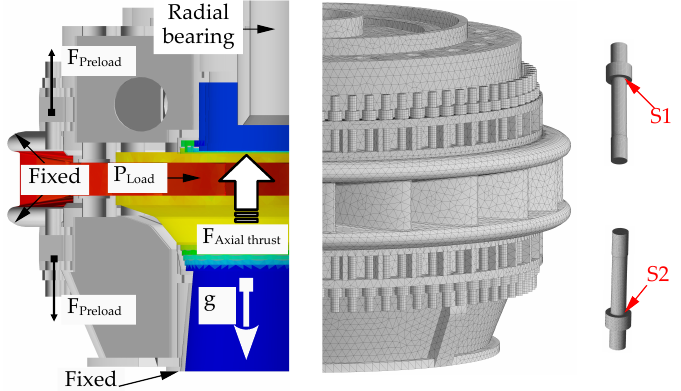
Figure 11. Simulation setup and finite element mesh of the stationary structure of the unit.